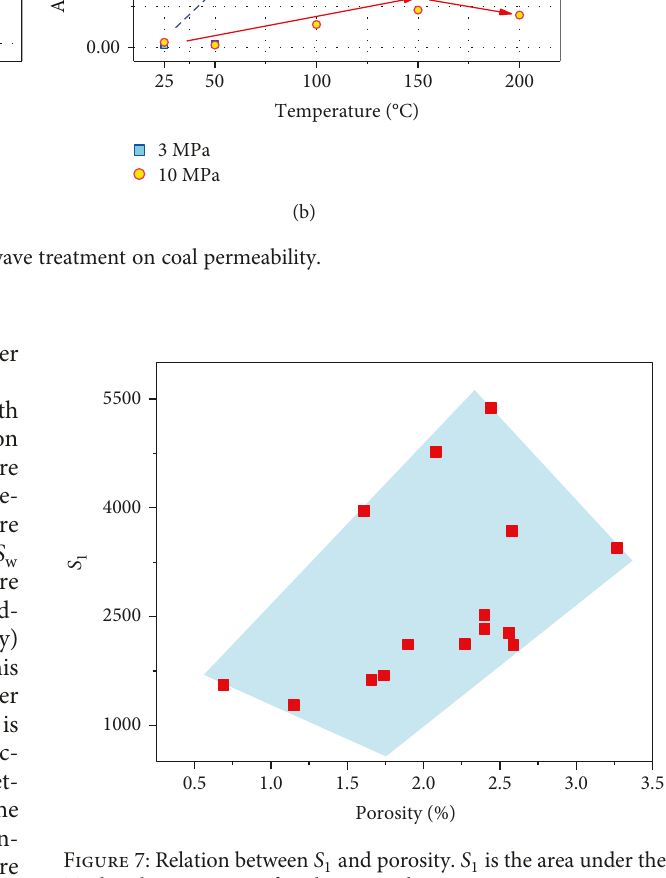
Figure 7: Relation between S T 2 distribution curve of coal cores without microwave